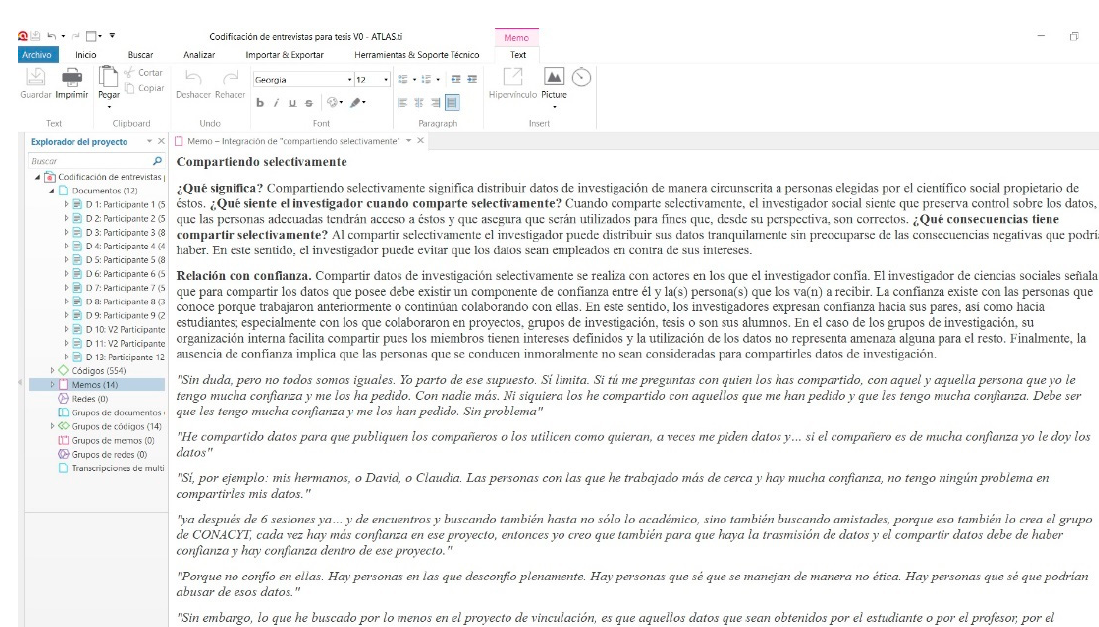
Figure 1. Codes generated in Atlas.ti 8.